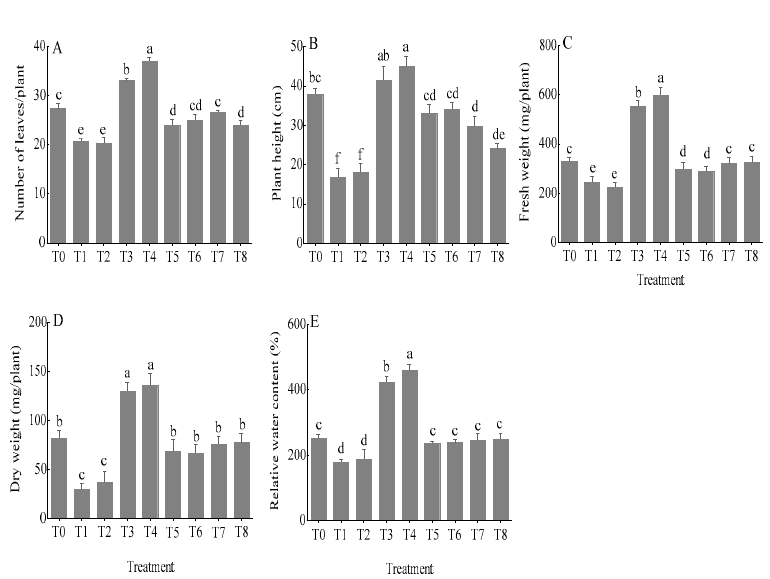
Figure 4. Effects of T. longibrachiatum (TL6 and TL3) on snow pea seedling biomass and relative water content at 21 days after pretreatment with F. solani (FSH) and F. avenaceum (FAH). ( A ) Number of leaves per plant; ( B ) plant height (cm); ( C ) leaves’ fresh weight (mg/plant); ( D ) leaves’ dry weight (mg/plant); ( E ) relative water content (%). Data are presented as mean ± standard errors (SE) of two independent experiments in three replicates. Means with the same lowercase letters are not significantly different at p < 0.05, according to Duncan’s multiple range tests.